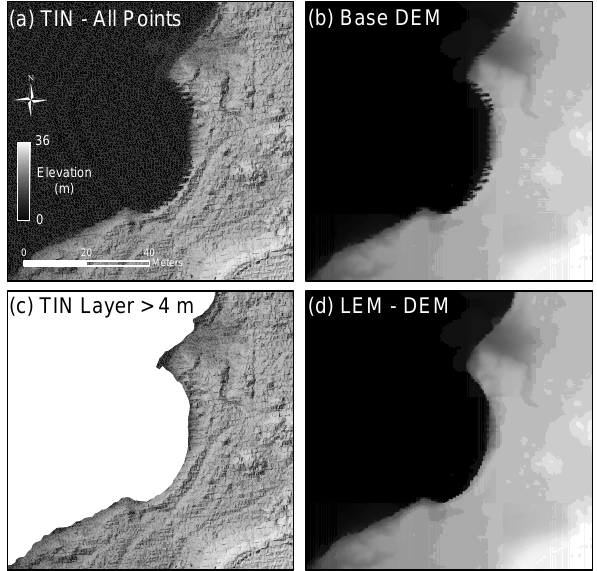
Fig. A1. Example of the “Layered Elevation Mosaic” – Digital Elevation Model (LEM-DEM) technique. (a) Initial TIN created from all points and the associated DEM (b) , showing how points collected in seacaves and notches produce pits and a jagged, incorrect cliff edge. (c) A TIN layer produced from points greater than 4m in elevation, showing the removal of seacave and notch points. (d) The final LEM-DEM which has eliminated the over vertical surfaces while maintaining the complex cliff topography and a well-defined cliff